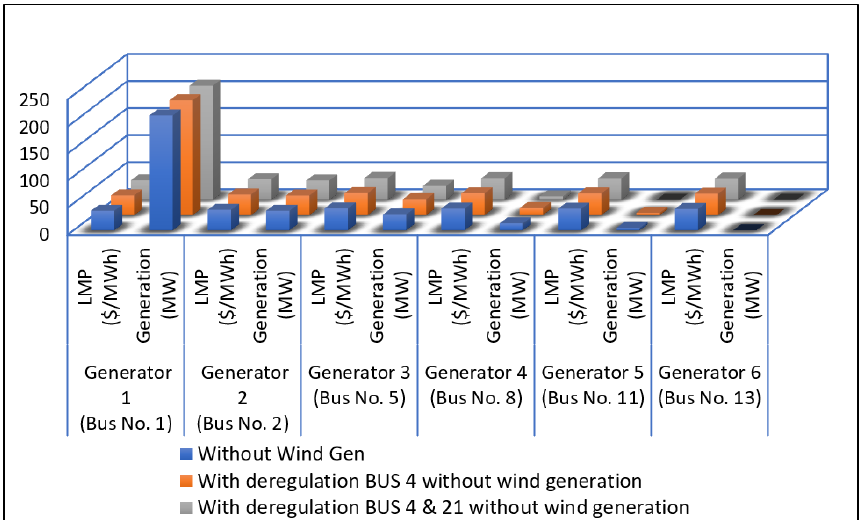
Figure 4. Generation (in MW) and LMP (in $/MWh) without wind placement.